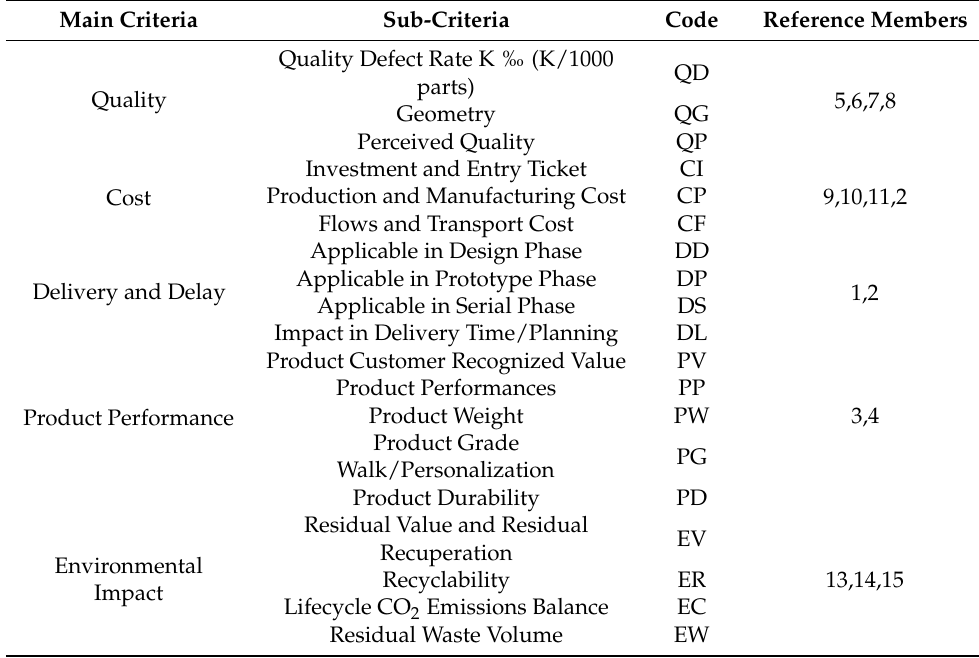
Table 2. Table of current main QCDP + E criteria, sub-criteria, and their codes. Main